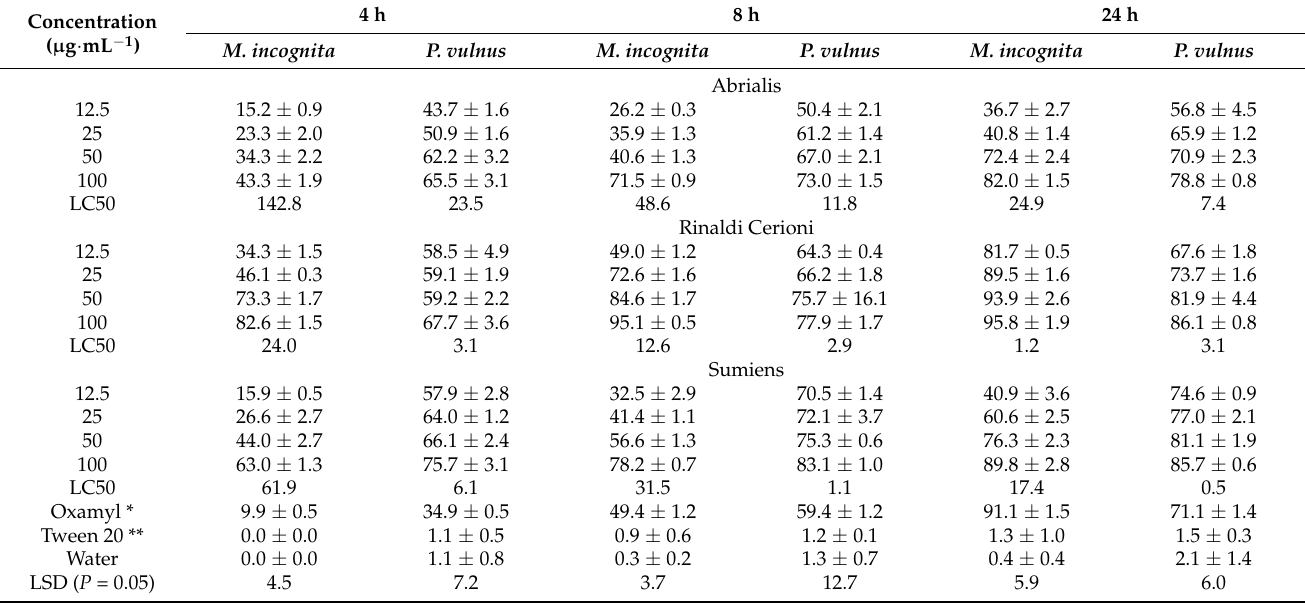
Table 2. Percentage mortality (means of four replicates ± SE) of Meloidogyne incognita J2 and mixed infective stages of Pratylenchus vulnus after 4, 8, or 24 h exposure to a 12.5–100 µ g · mL − 1 range of concentrations of EOs from lavandin cv Abrialis, Rinaldi Cerioni, and Sumiens.